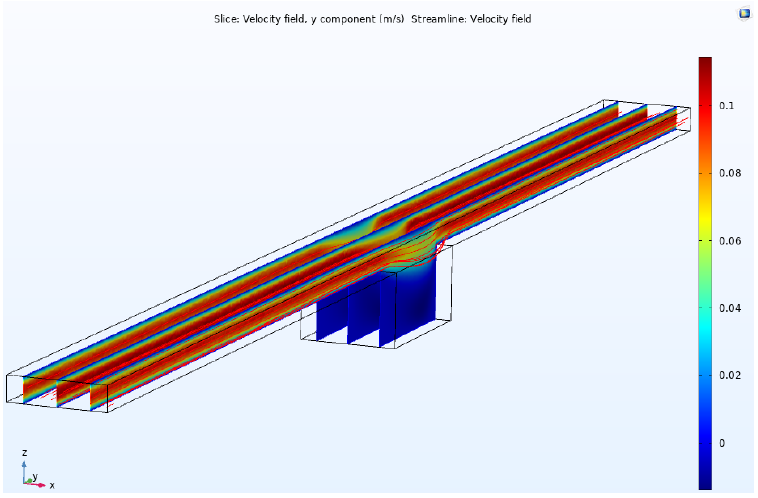
Figure 16. Flow velocity contour in the microfluidic channel for 260 mg/s inlet mass water flow rate.